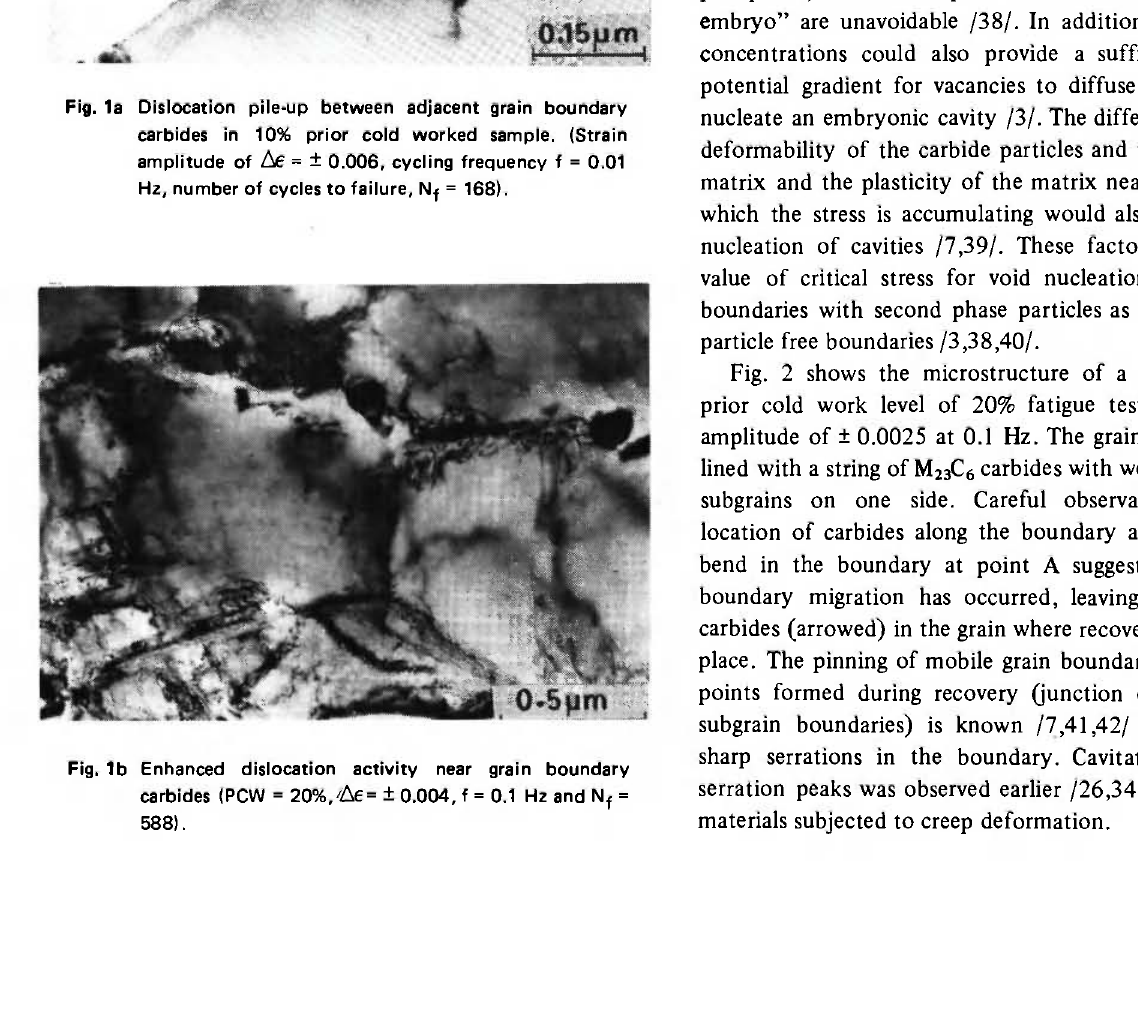
Fig. 1b Enhanced dislocation activity near grain